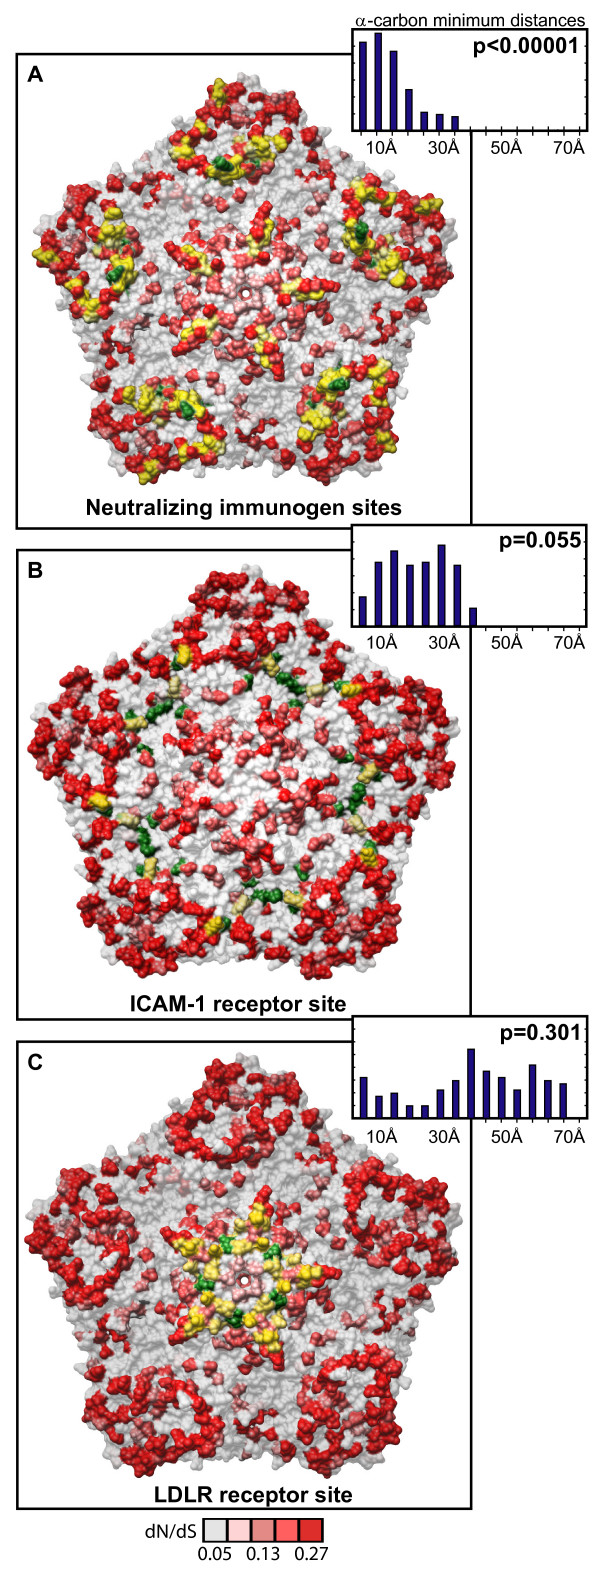
Distribution of diversifying capsid residues relative to functional domains. Diversifying residues in the HRV2 capsid pentamer (Verdauger et al., 2000) overlaid onto the characterized HRV antigenic sites (Appleyard et al., 1990; Hastings et al., 1990; Speller et al., 1993; Hewat and Blaas, 1996; Hewat et al., 1998). B. Diversifying residues in the HRV16 capsid pentamer (Hadfield, et al., 1997) overlaid onto the characterized ICAM1 cellular receptor contacts (Bella et al., 1999). C. Diversifying residues in the HRV2 capsid pentamer (Verdauger et al., 2000) overlaid onto the characterized LDLR cellular receptor contacts (Verdauger et al., 2004). Diversifying residues are shown in red, shaded according to corresponding dN/dS values as indicated by the scale bar below panel C; green, antigenic residues (A); ICAM1 receptor contacts (B), and LDLR contacts (C); yellow, diversifying residues that directly overlap functional residues. Inset histogram, distribution of minimal distances between α-carbons of diversifying residues and antigenic sites (A), ICAM1 contact residues (B), and LDLR contact residues (C); Y-axis is simple frequency count, with a range that varies for each panel; p values provide frequency at which an average minimum distance similar to that for the observed distribution was detected when the locations of the diversifying residues were randomized on each pentamer surface, and minimal distances to antigenic site residues (A), ICAM1R contact residues (B), and LDLR contact residues (C) were measured (n = 100,000 randomizations).